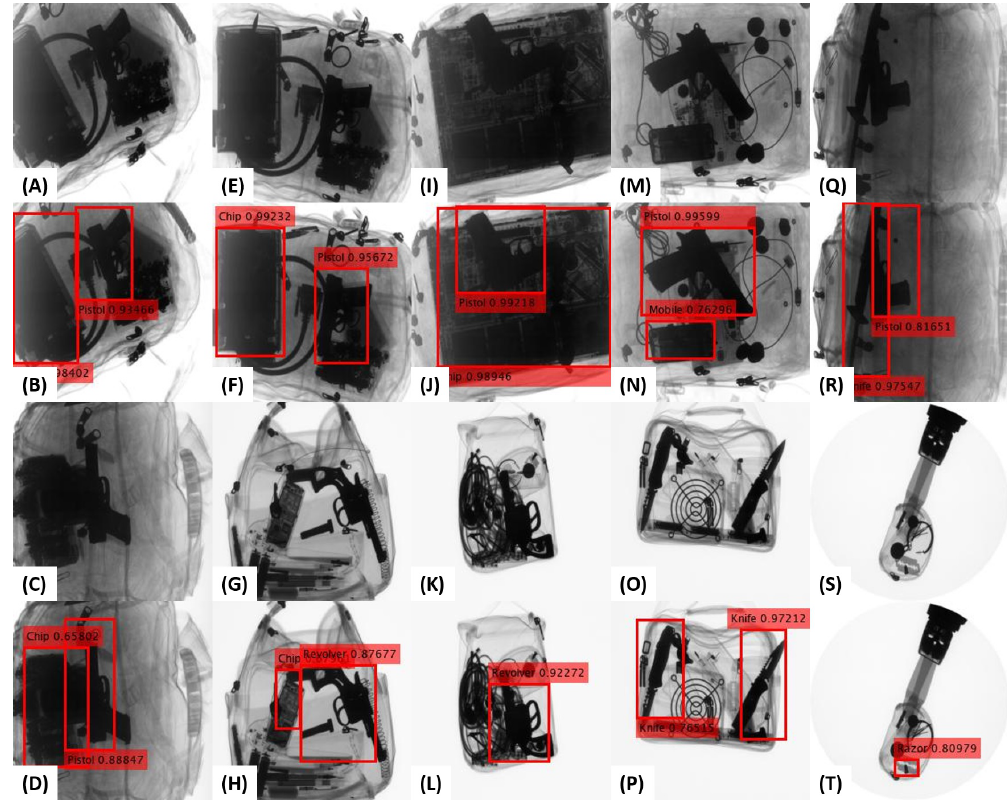
Figure 4. Qualitative performance of the proposed framework on the GDXray [15] dataset for detecting contraband items such as pistols , revolvers , razors , chips , mobile phones , and knives as shown in ( A – T ). Moreover, first and third row show the original scans. We can appreciate the detection of concealed pistol in ( B , F ), concealed pistol and a laptop ( chip ) in ( J ), the cluttered pistol and knife in ( R ), cluttered revolver in ( L ), and low contrasted razor in ( T